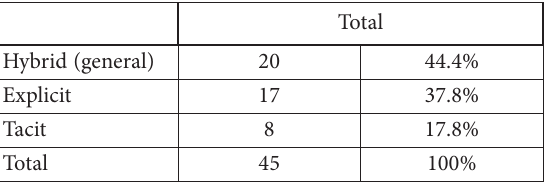
Table 3. Types of knowledge studied (source: authors, 2018)